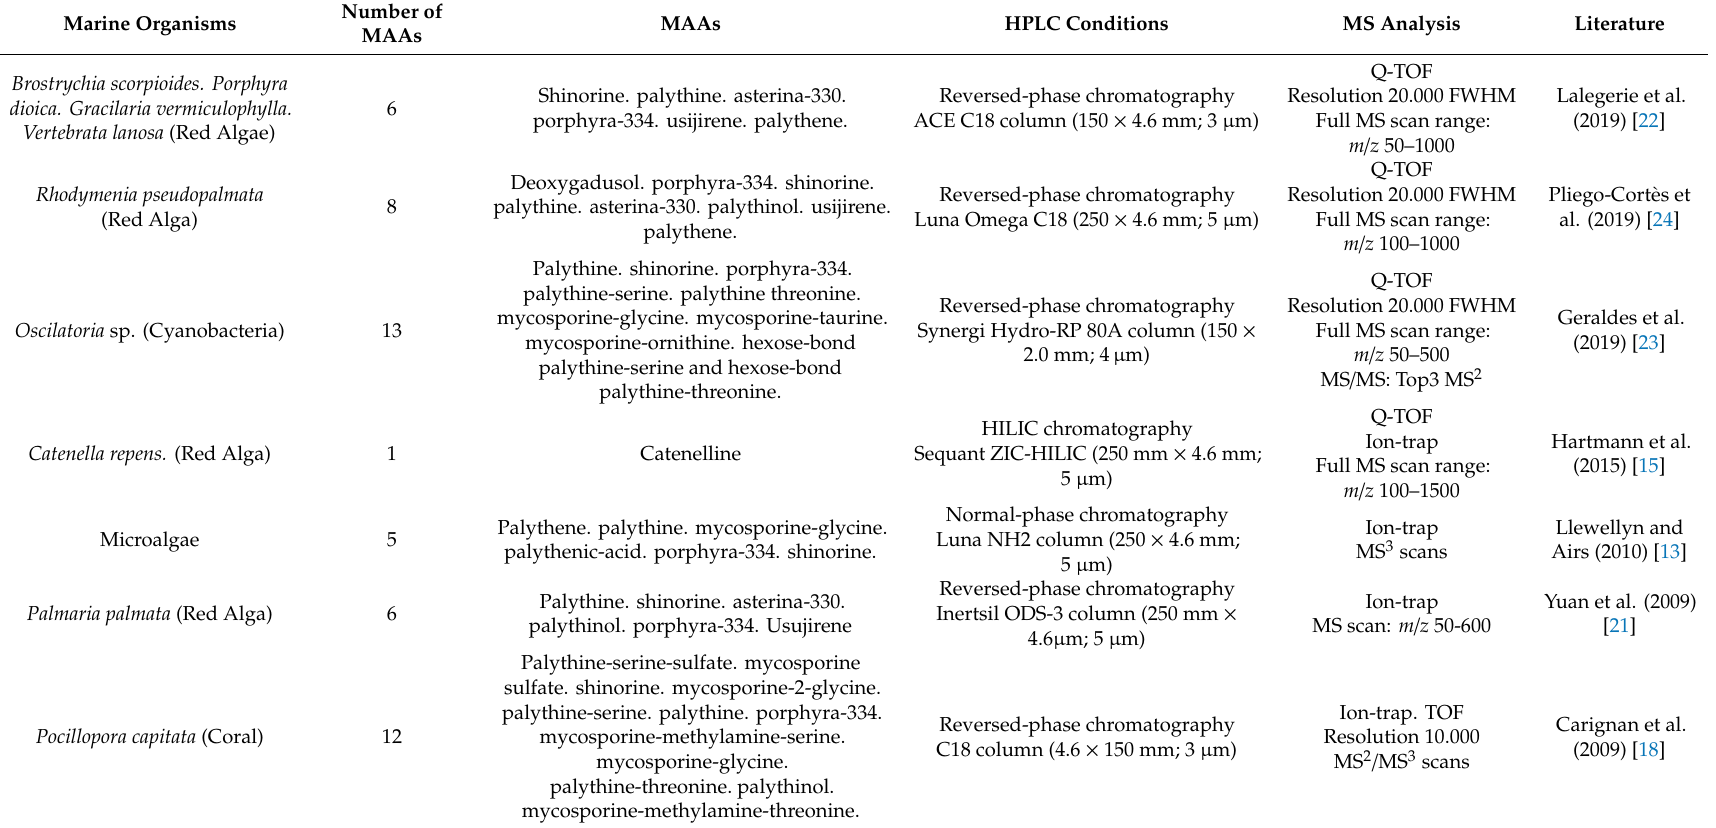
Table 2. Inventory of MAAs identified in targeted HPLC-ESI-MS methods operated in positive